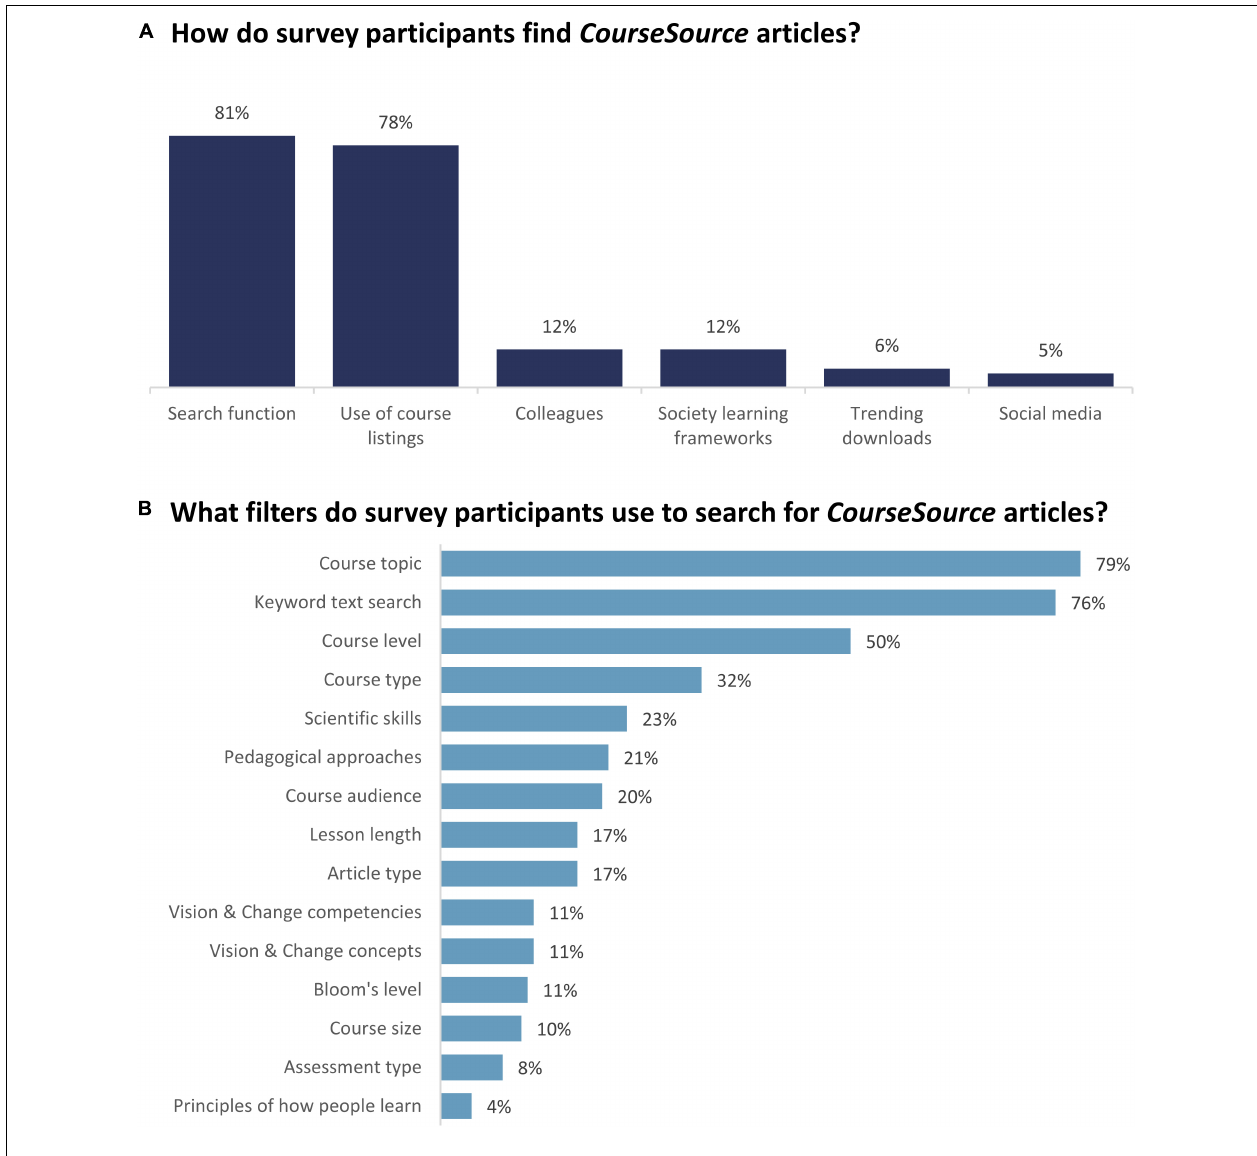
FIGURE 4 | Survey participants’ Search engagement based on (A) how they find new articles and (B) which search filters they use. Filters represent what is available on the CourseSource website. A description of filters is included in “Materials and Methods”